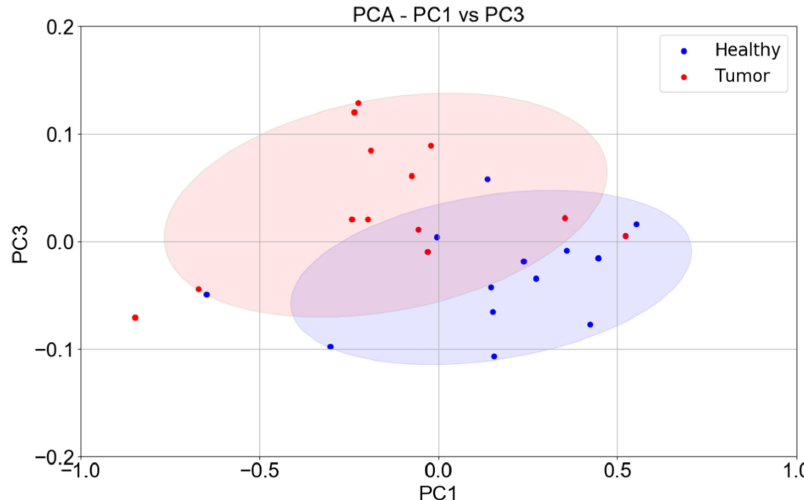
Figure 3. PCA (principal component analysis) of sensor responses—PC1 vs. PC3. PCA score plot (blue points: healthy tissues; red points: tumor tissue) constructed with the responses ( n =13) of the ST25, W11, and TiTaV sensors only.